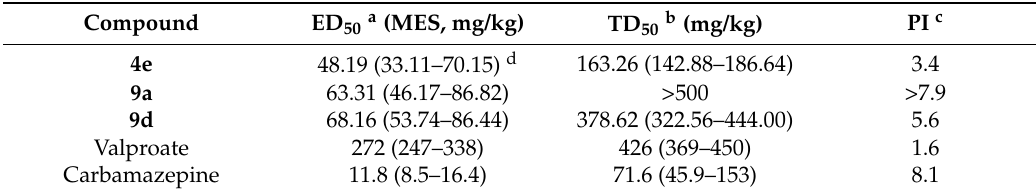
Table 2. Phase-II quantitative anticonvulsant evaluation in mice